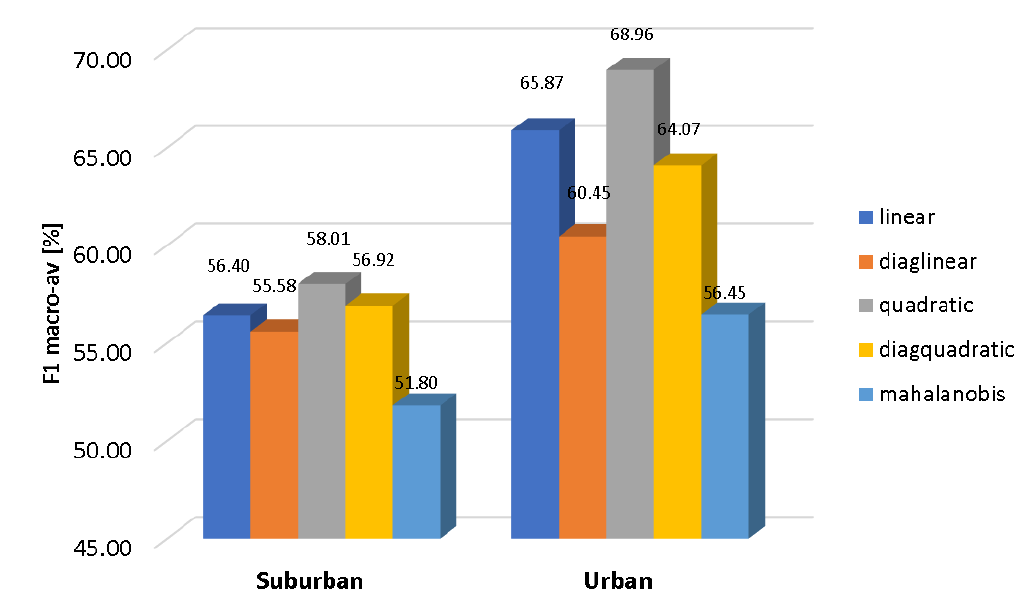
Figure A1. DA optimization results using the real-life suburban and urban databases, respectively. A different discriminant function has been used for each experiment (see the figure legend).